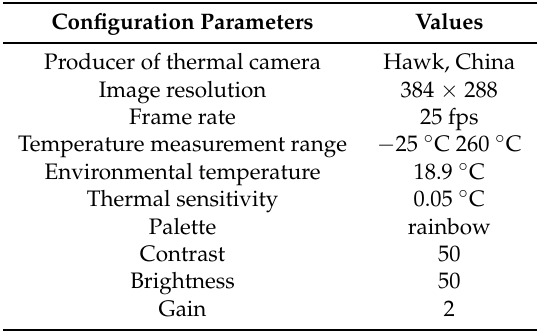
Table 1. Configuration parameters setting of the thermal camera.